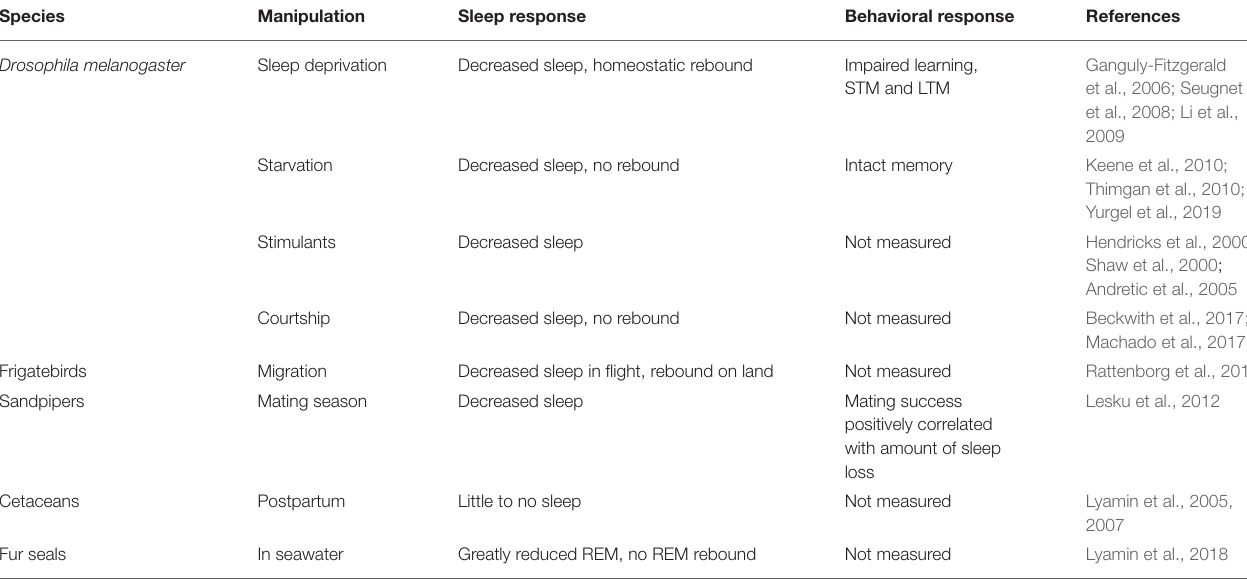
TABLE 1 | Summary of experimental or ethologically-relevant conditions that reduce sleep in several species.